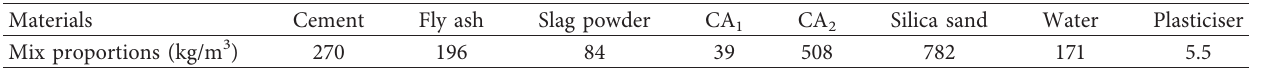
Table 2: Self-compacting concrete mix proportions.